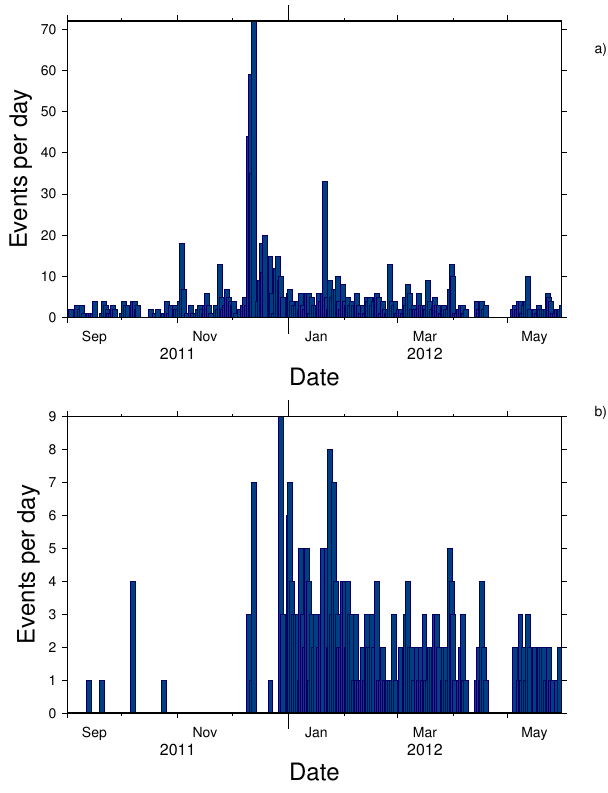
Fig. 13. Evolution of the seismic activity rate of Santo Antão for volcano-tectonic events (a) and for medium-frequency events (b) .